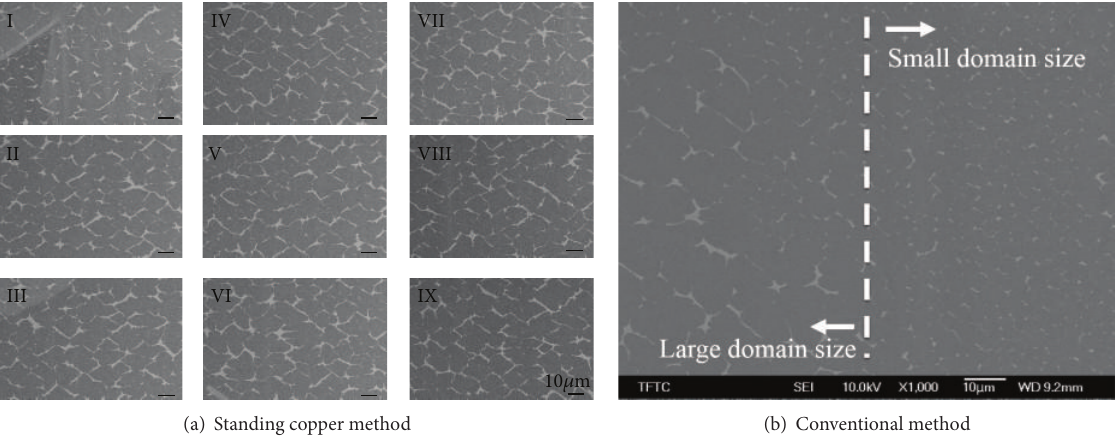
Figure 2: (a) SEM images show the distribution of graphene domains on the standing copper foil (the scale bars are 10 𝜇 m). (b) SEM image shows the poor distribution of graphene domains on copper foil with conventional